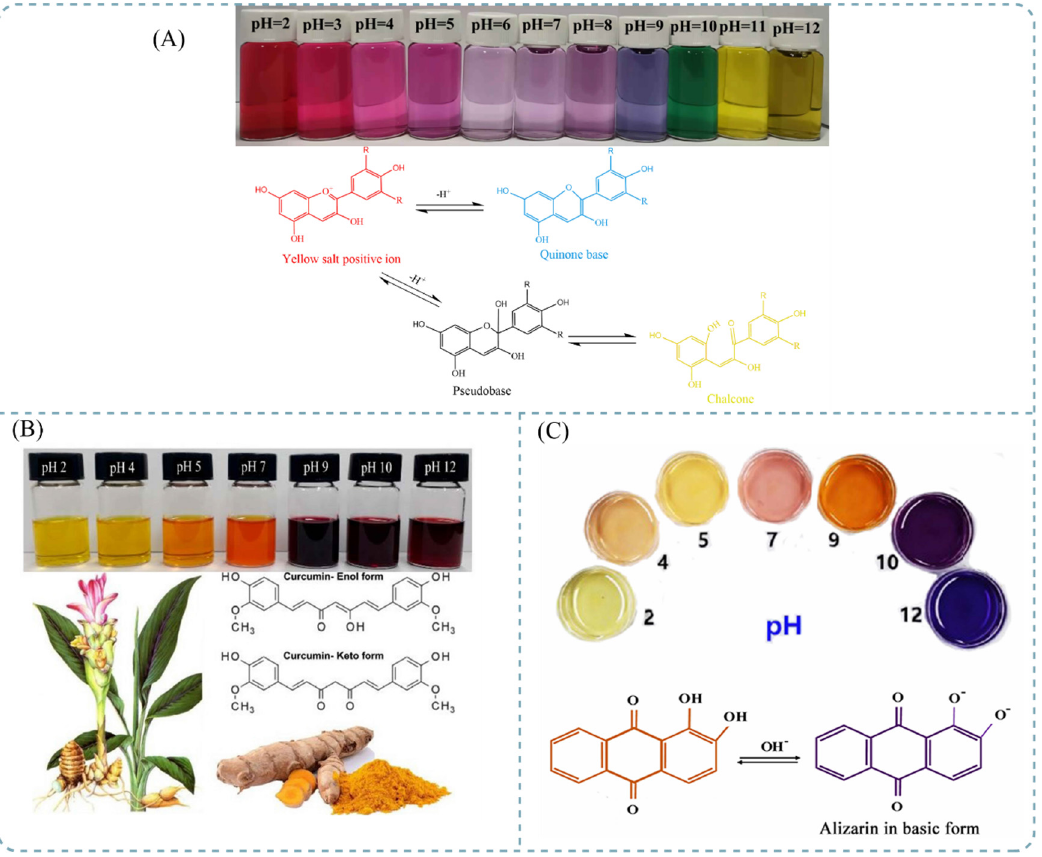
Figure 2. Color changes and mechanisms for: ( A ) anthocyanins [5]; ( B ) curcumin [76]; ( C ) alizarin at different pH values [77]. Source: reprinted with permission from Liu et al. [5], 2021, Elsevier; Ezati et al. [76], 2020, Elsevier; and Roy et al. [77], 2021, ACS.